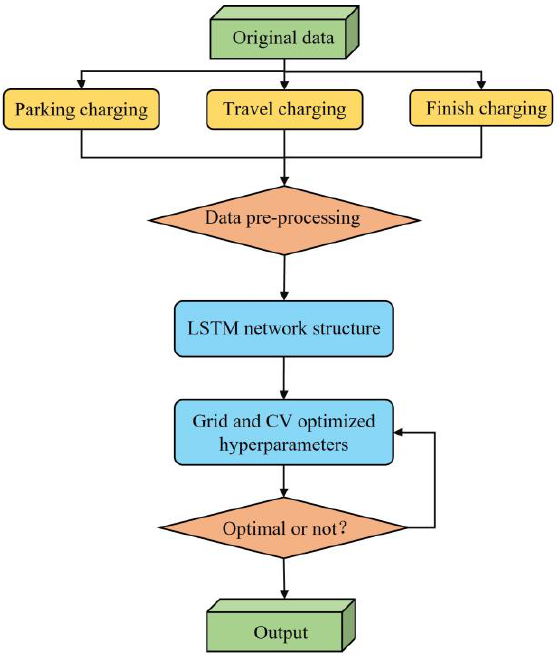
Figure 1. The proposed GSCV optimisation-based LSTM network for SOC estimation process.